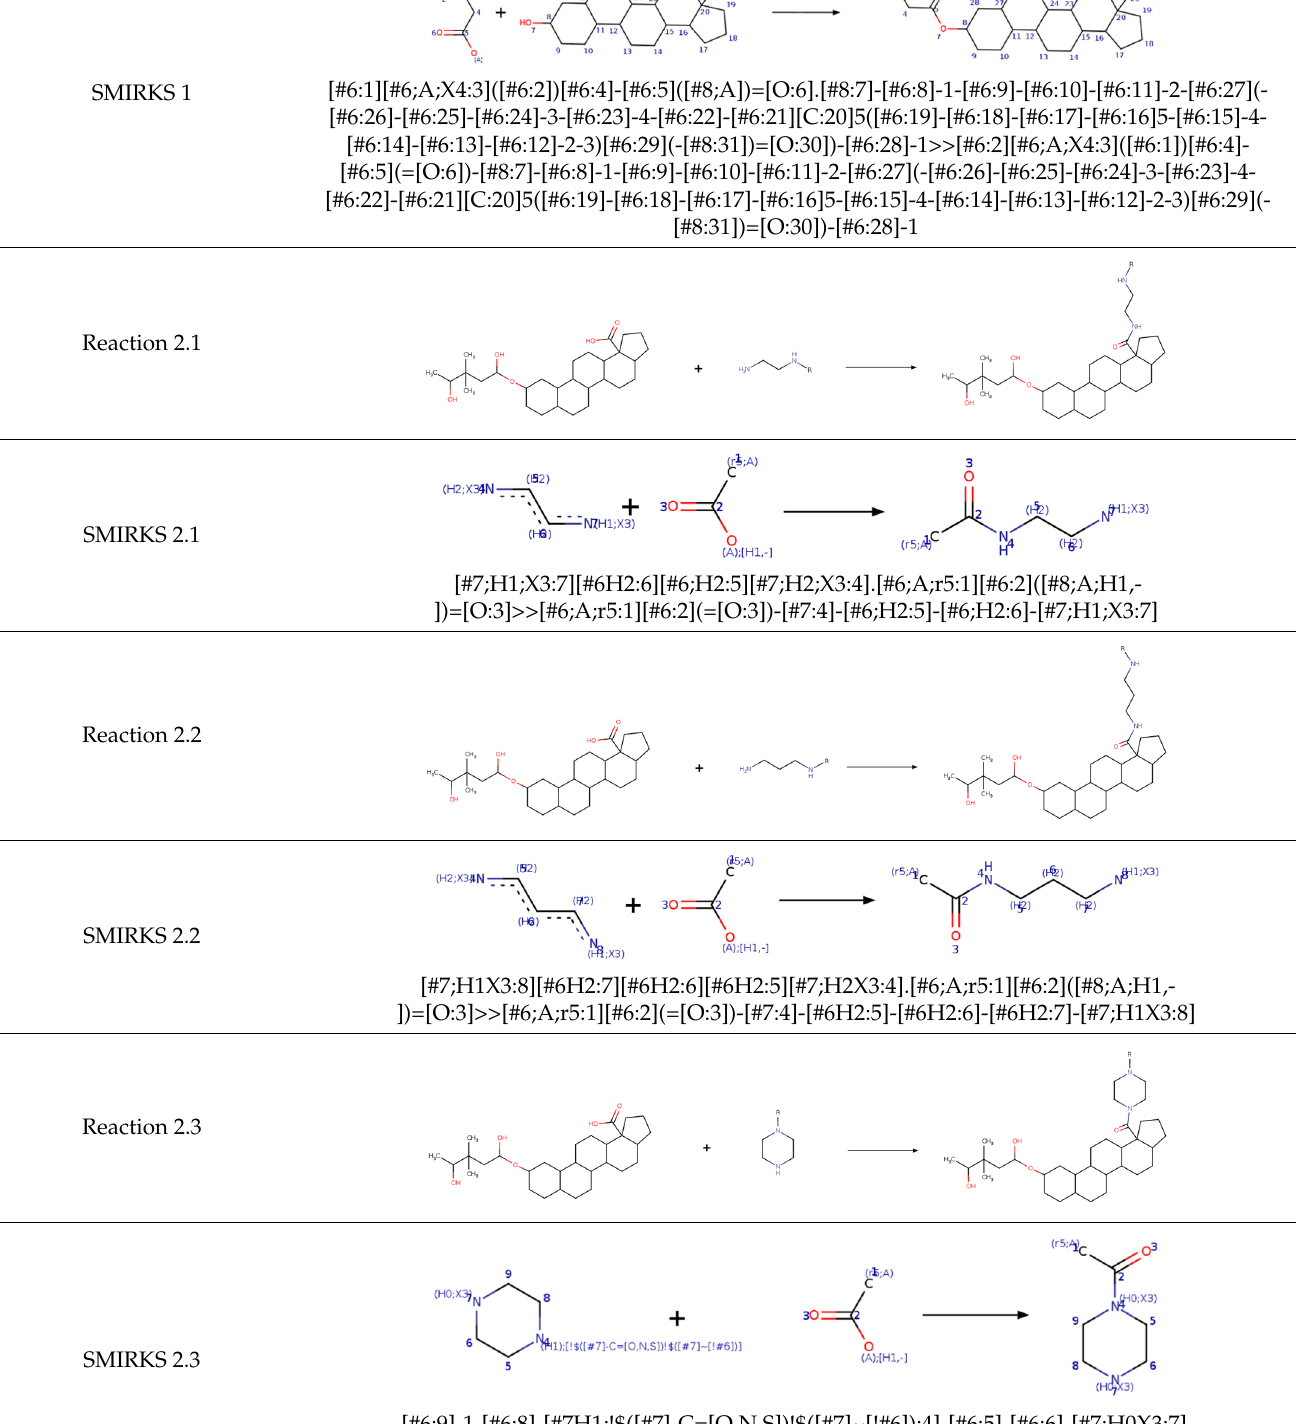
Table 3. Functional groups using SMARTS notation to filter fragments from natural products. Functional Groups SMARTS Aliphatic alcohol (cyclohexa-